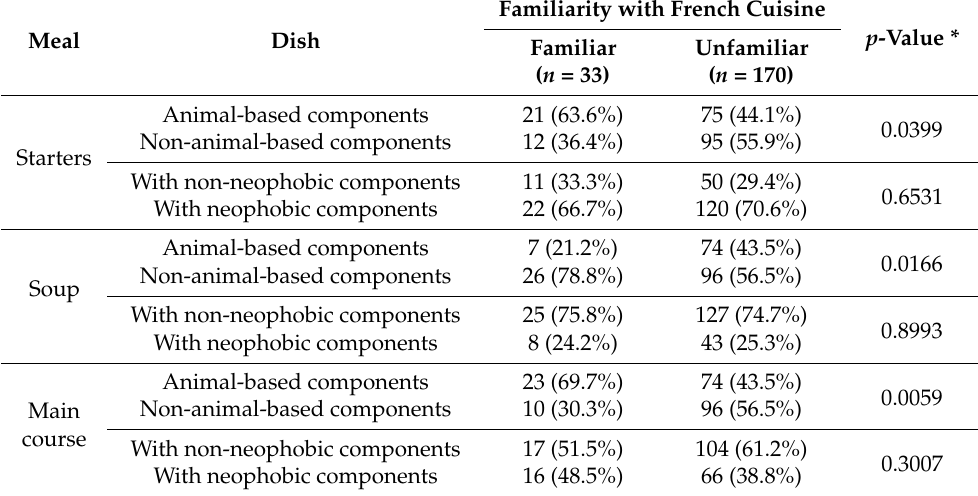
Table 9. The dish choices made by the studied sample of young Polish women from the model French restaurant menu. The dishes are organized within sub-groups of those containing animal- based components/non-animal-based components, or those with non-neophobic components/with neophobic components, and are stratified according to the respondents’ familiarity with French